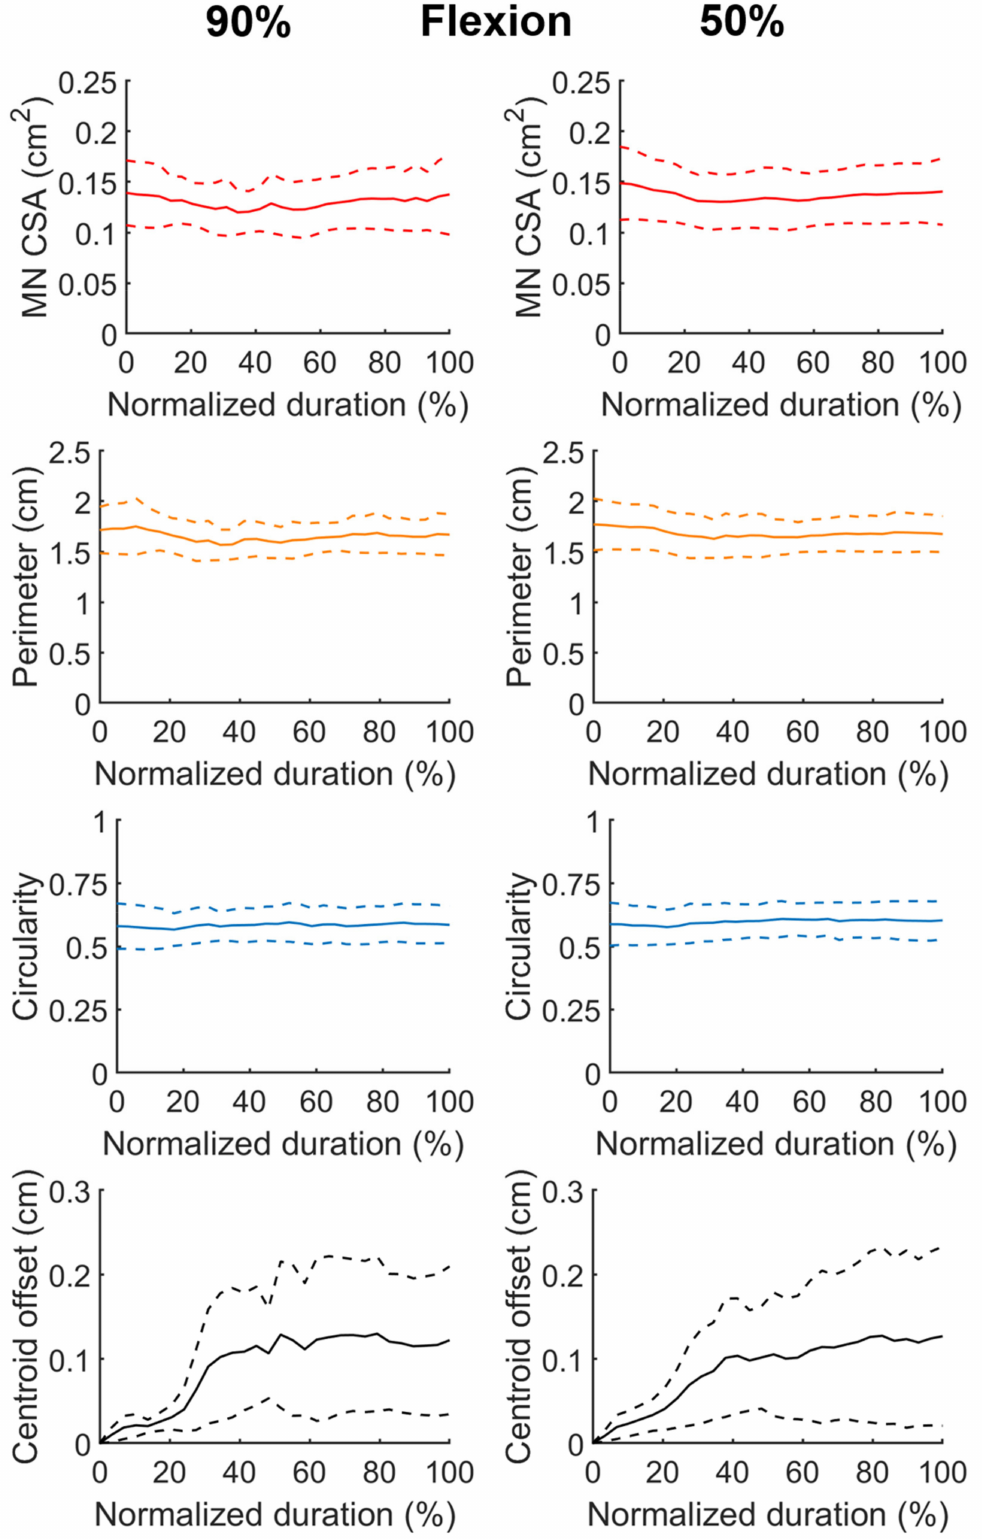
Figure 4. Temporal profiles of the morphological characteristics of inferred MNs during fingers flexion, including the CSA and the perimeter of the nerve, the MN circularity, and the centroid displacement throughout the motion. The phase duration was rescaled by normalization. The data shown in the left and right column were pooled from the data of duration confined by the D 90 and D 50 defined in Figure 3, respectively. In individual panel, the solid line represents the average of the resampled data, and the dash lines stand for average plus and minus one standard deviation,